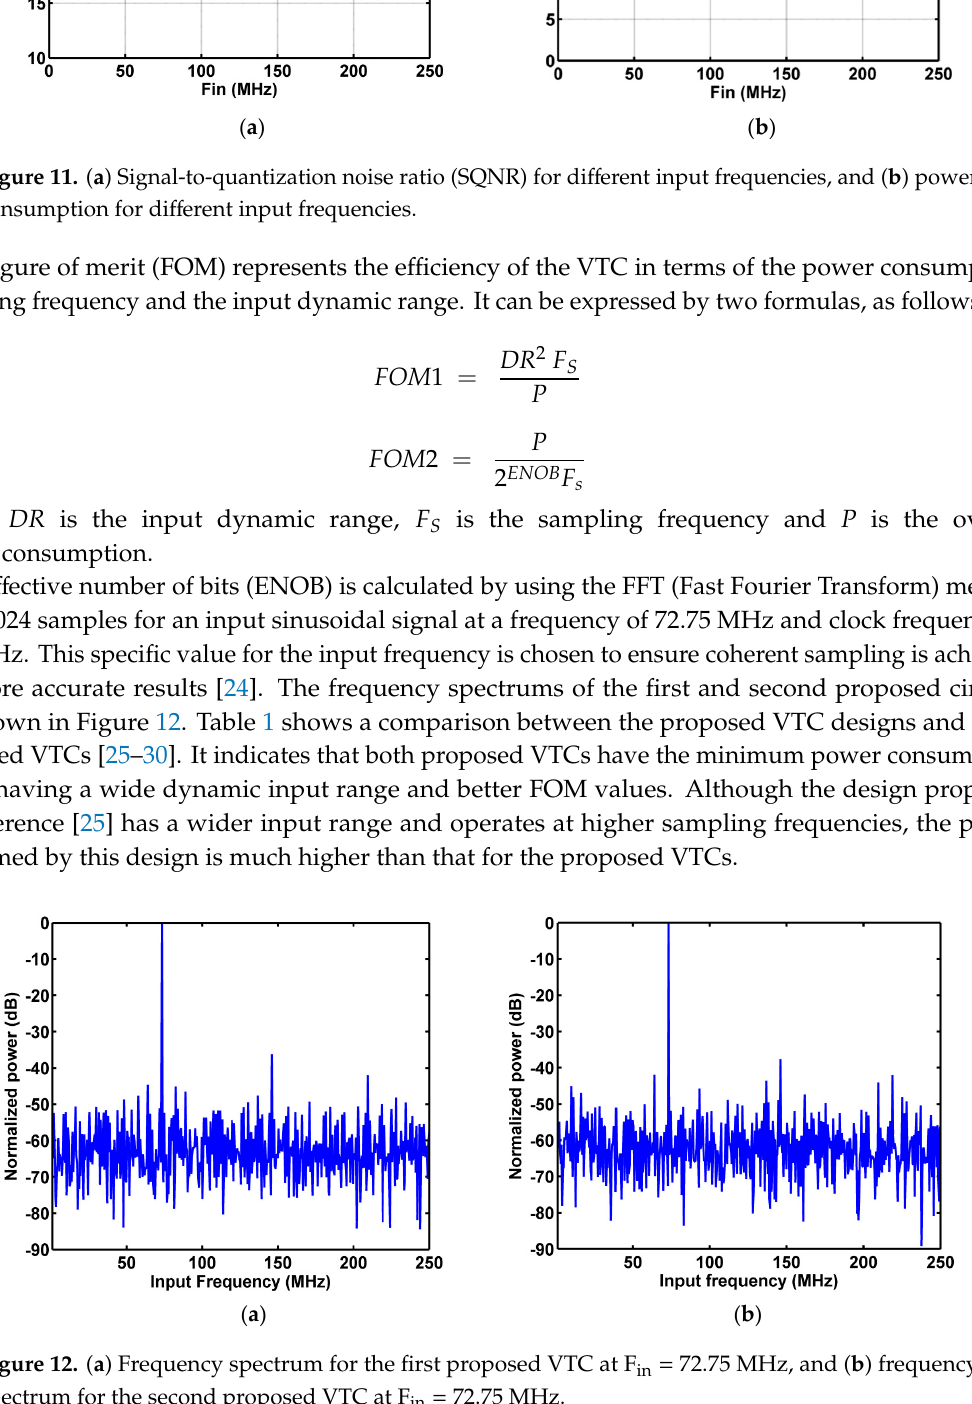
Figure 12. ( a ) Frequency spectrum for the first proposed VTC at F in = 72.75 MHz, and ( b ) frequency spectrum for the second proposed VTC at F in = 72.75 MHz.